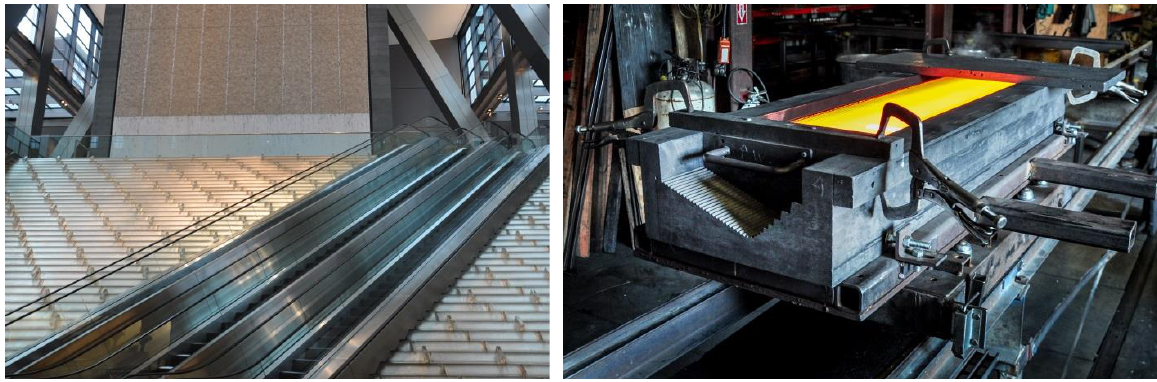
Fig. 12 The Ice Falls project (left) and the adjustable graphite moulds (right) used by the John Lewis Glass Studio for the casting of the